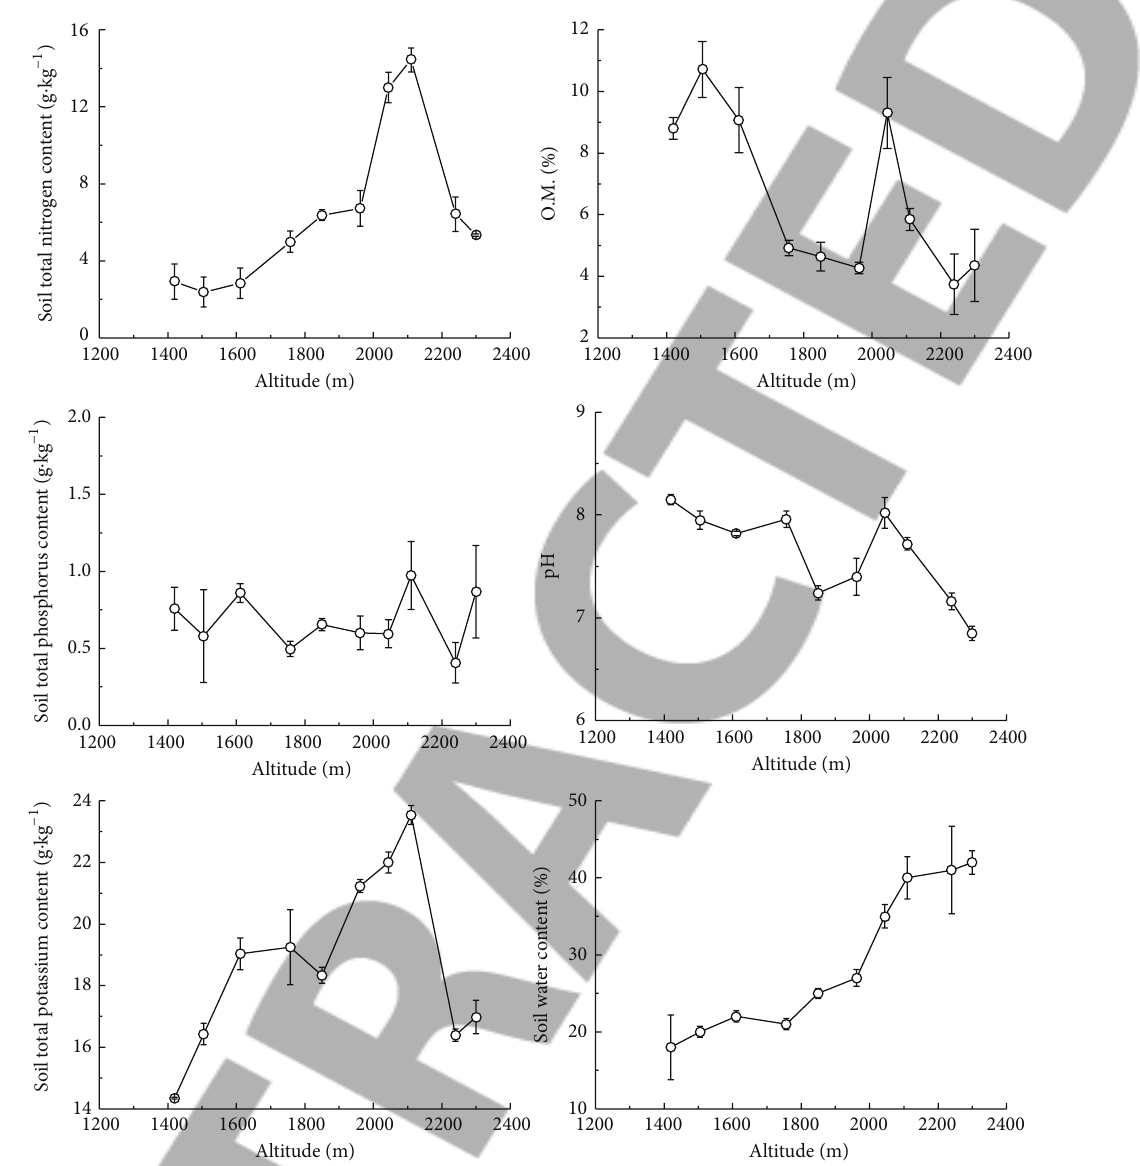
Figure 2: Relationships between altitude and soil properties (values are means ± standard